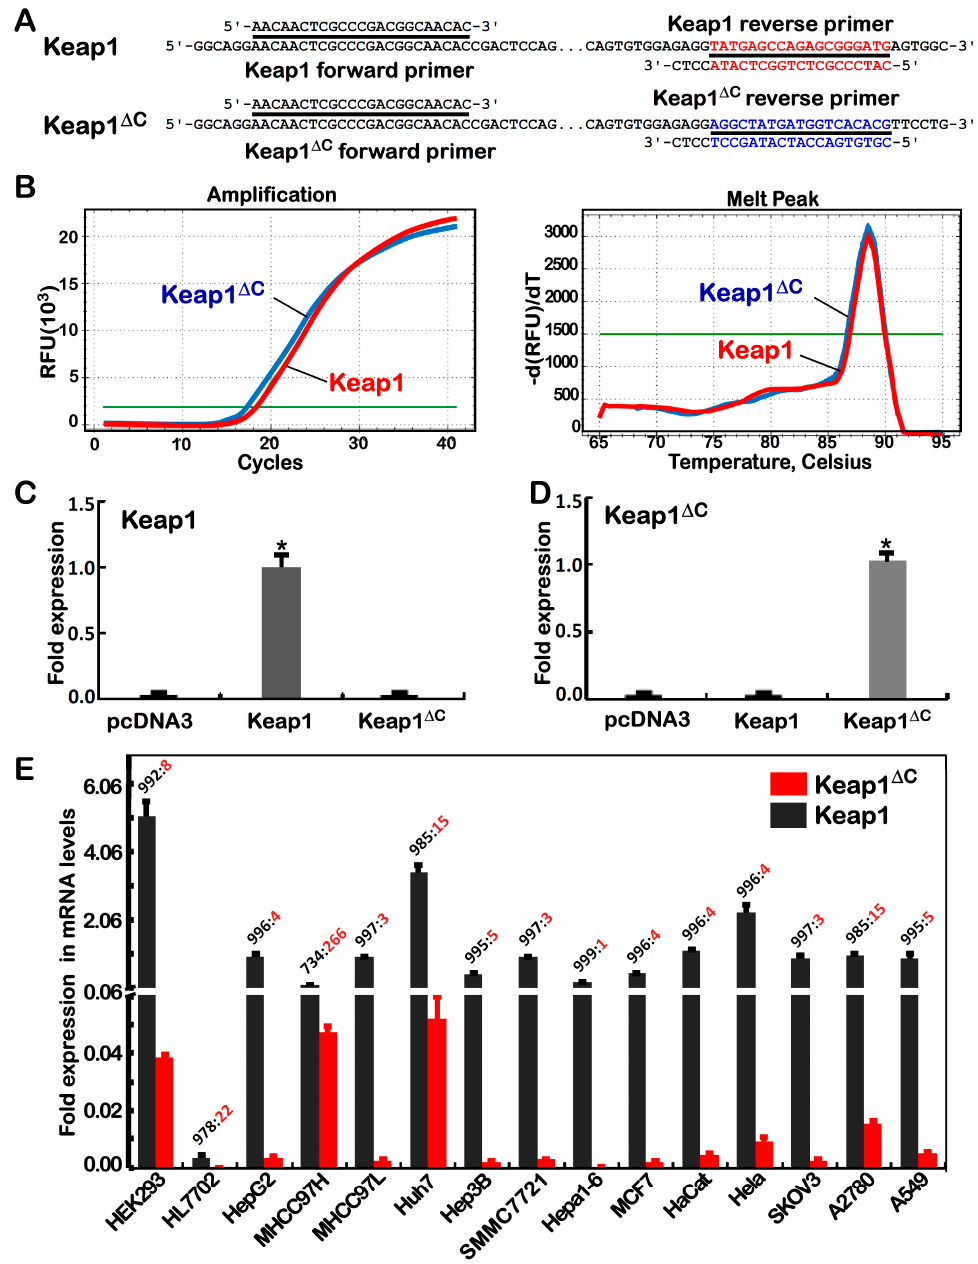
Figure 2. Distinctive expression of Keap1 Δ C in different cell lines. ( A ) Two pairs of primers were designed for specific amplification of Keap1 and Keap1 Δ C . Their forward primers were identical, but their reverse primers had only four identical bases at the 3 ′ ends, the different colors means the difference in downstream primers. ( B ) The Keap1 - and Keap1 Δ C -specific primers were identified by almost overlapped amplification curves ( left ) and melting curves ( right ) of real-time qPCR. ( C , D ) Two distinct expression constructs for Keap1 and Keap1 Δ C were transfected into HepG2 cells. The total RNAs were extracted and subjected to real-time qPCR to detect distinctive expression of Keap1 - and Keap1 Δ C -specific mRNAs ( * p < 0.01, n = 3 × 3), respectively. ( E ) Different expression ratios of Keap1 to Keap1 Δ C at mRNA levels were determined by real-time qPCR analysis of 15 distinct cell lines as indicated.